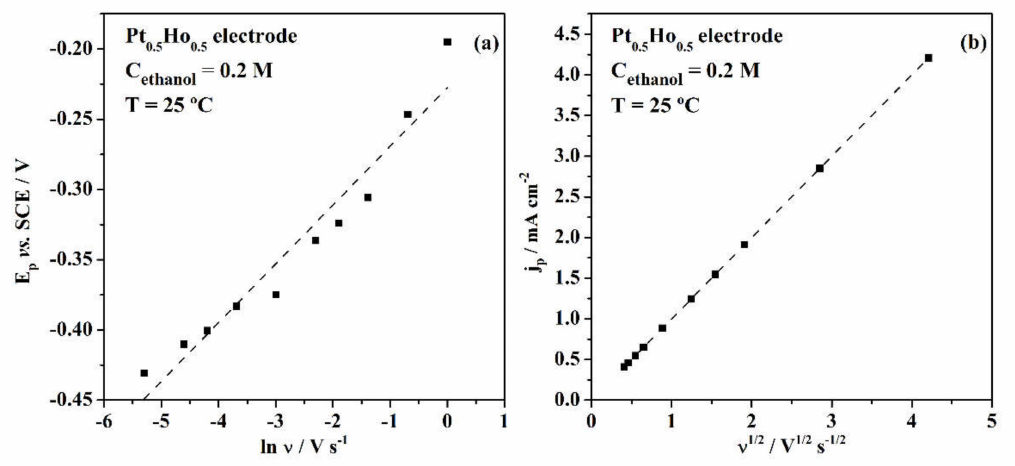
Figure 5. ( a ) E p vs. ln ν and ( b ) j p vs. ν 1 / 2 plots for Pt 0.5 Ho 0.5 electrode in 0.2 M ethanol + 2 M NaOH, at 25 ◦